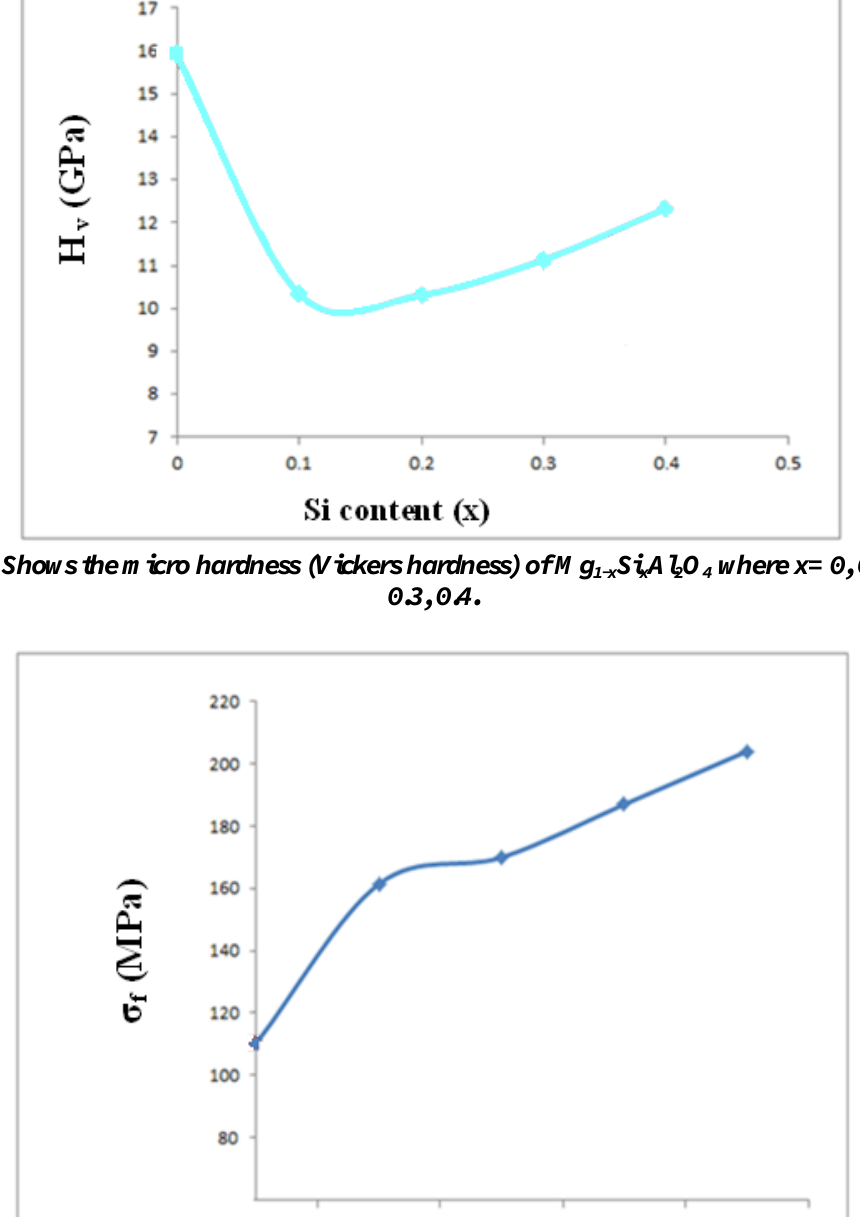
Fig. 8: A plot diametrical compression ( ) against Si addition % of Mg x= 0, 0.1, 0.2, 0.3,